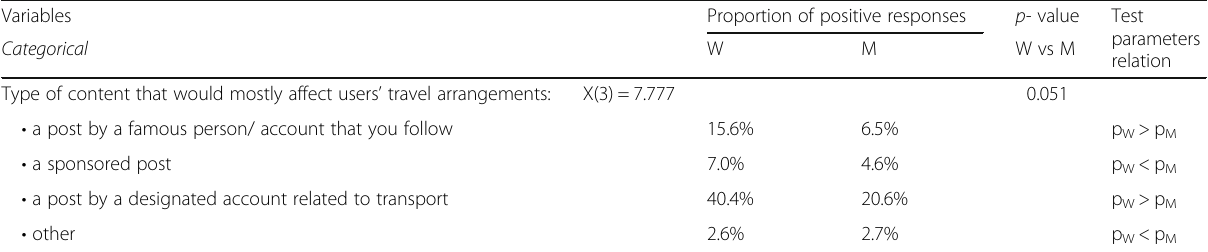
Table 7 Summary of test results on preferable social media type about traveling possibilities Variables